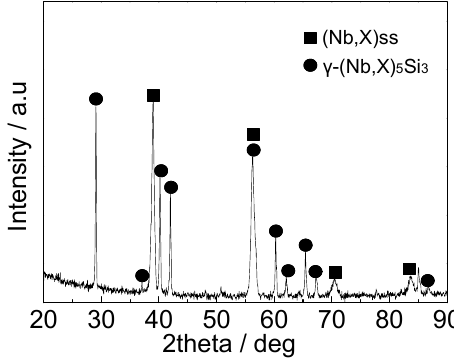
Figure 3. XRD (X-ray diffraction) patterns of the master alloy.